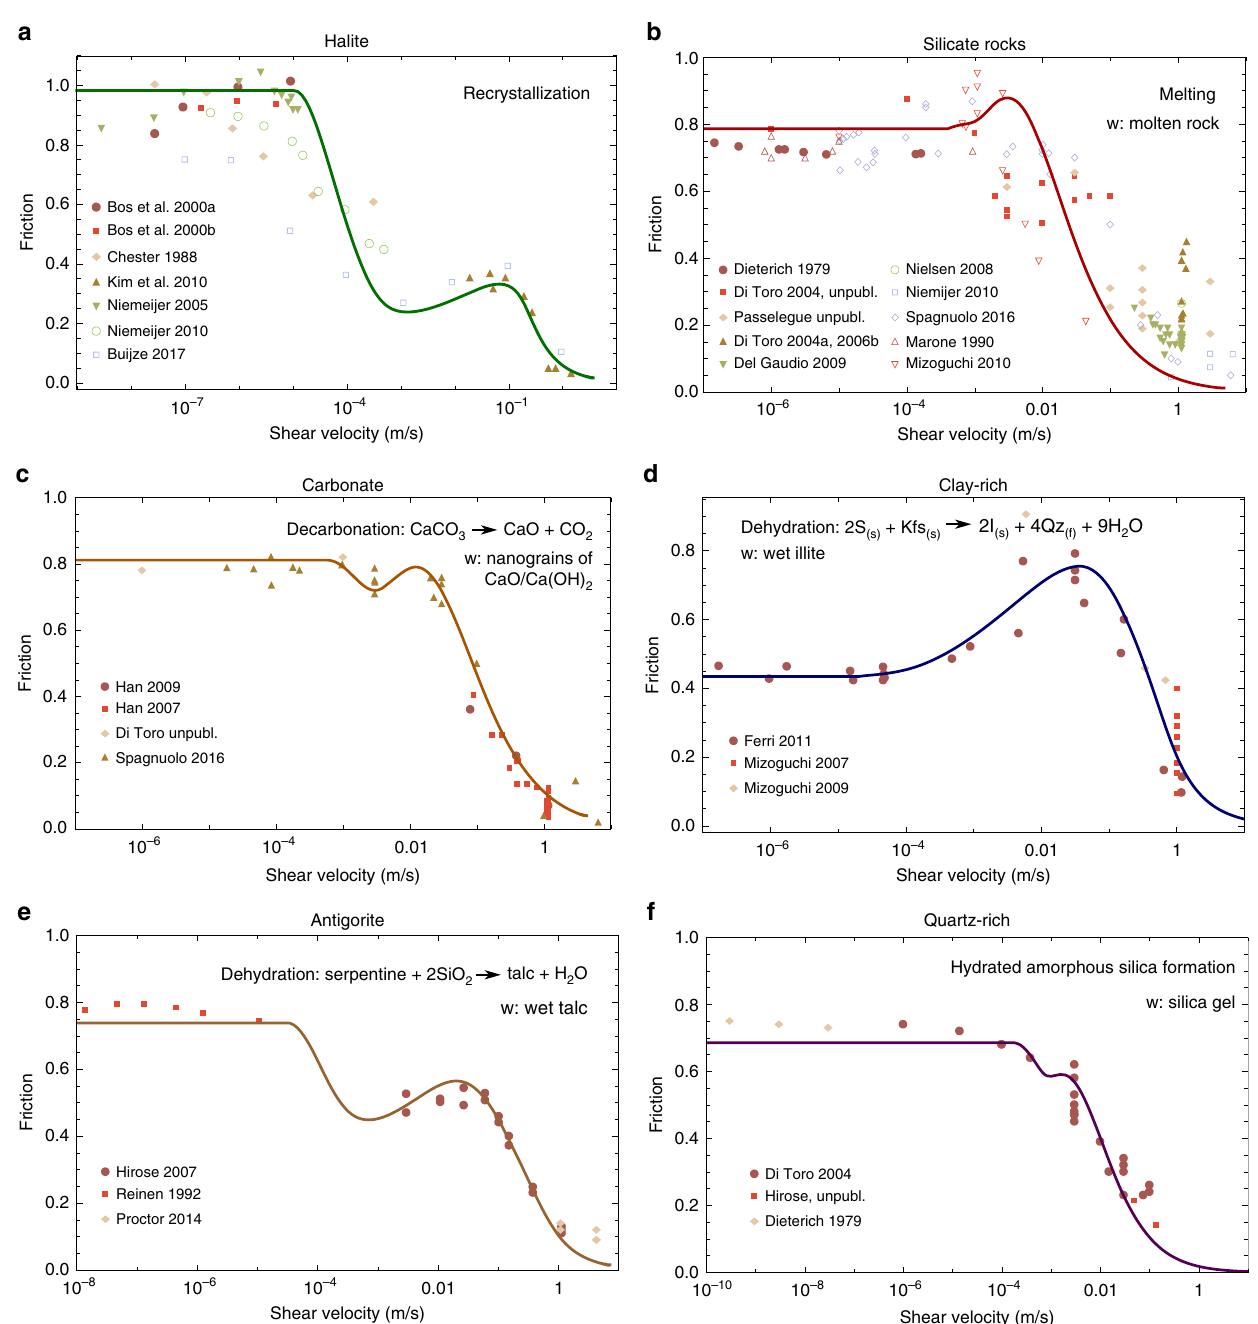
Fig. 3 Results of the model for different types of materials. Application of the mathematical model (solid lines) to literature data (dots) of the friction coef fi cient as a function of the velocity. See the Methods for the mathematical description, Fig. 2 for the qualitative steady-state response and Supplementary Tables 4 – 18 for the references of the experimental data. For each material, the phase transformation and the associated weak phase are indicated. a For halite rock. The model reproduces the experimental behavior with α = 0. b For silicate rocks ( α = 7.5). c For carbonate rocks ( α = 5.3). d For clay-rich rocks ( α = 2). e For antigorite ( α = 1.5). f For quartz-rich rocks ( α =